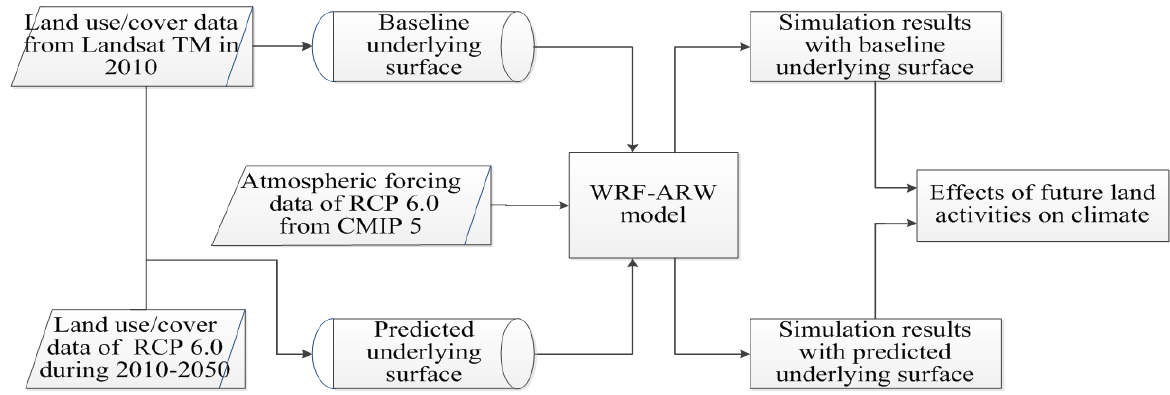
Figure 2. Downscaling scheme using WRF-ARW model for the four case